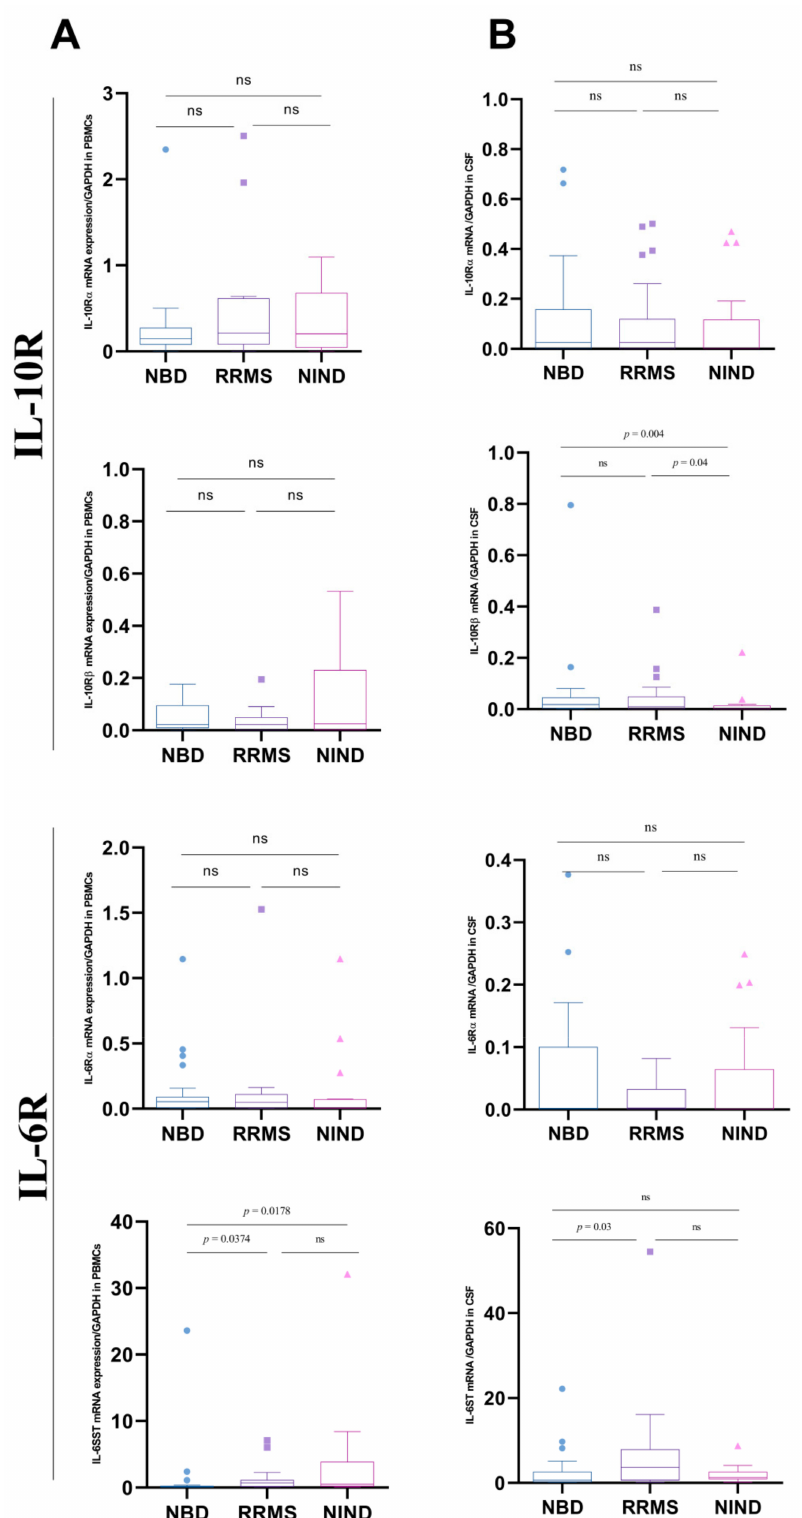
Figure 4. Boxplots representation of subunits of IL-10 and IL-6 receptors expression in CSF and PBMCs cells of patients and controls. ( A ) Blood expression of IL10RA, IL10RB, IL6R, and IL6ST in NBD ( n = 21), RRMS ( n = 23) and NIND ( n = 19). ( B ) CSF expression of IL10RA, IL10RB, IL6R, and IL6ST in NBD, RRMS and NIND. Statistical significance between the two groups was assessed using the Wilcoxon–Mann–Whitney test; ns = non